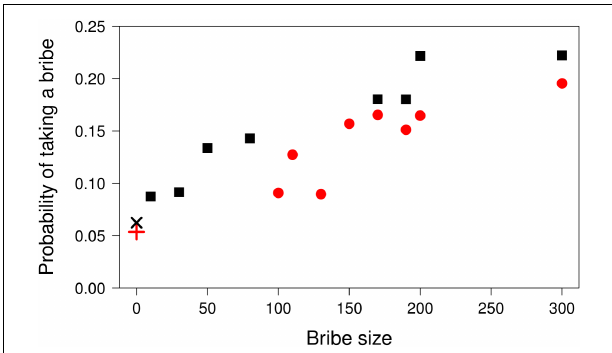
FIGURE 3 | The effect of bribe size on the probability of taking the bribe. The figure shows the average probability of taking a bribe in trials with misaligned classification criteria depending on the bribe size. The displayed points are computed across all participants and trials separately for the low bribe condition (black squares and saltire) and high bribe condition (red dots and cross). It is possible to see that the probability of taking a bribe increases with larger bribes and that participants are more likely to classify an object according to its shape when a bribe was present (squares and dots) than when it was absent (saltire and cross). Note that the abscissa ends at the probability of 0.25, not